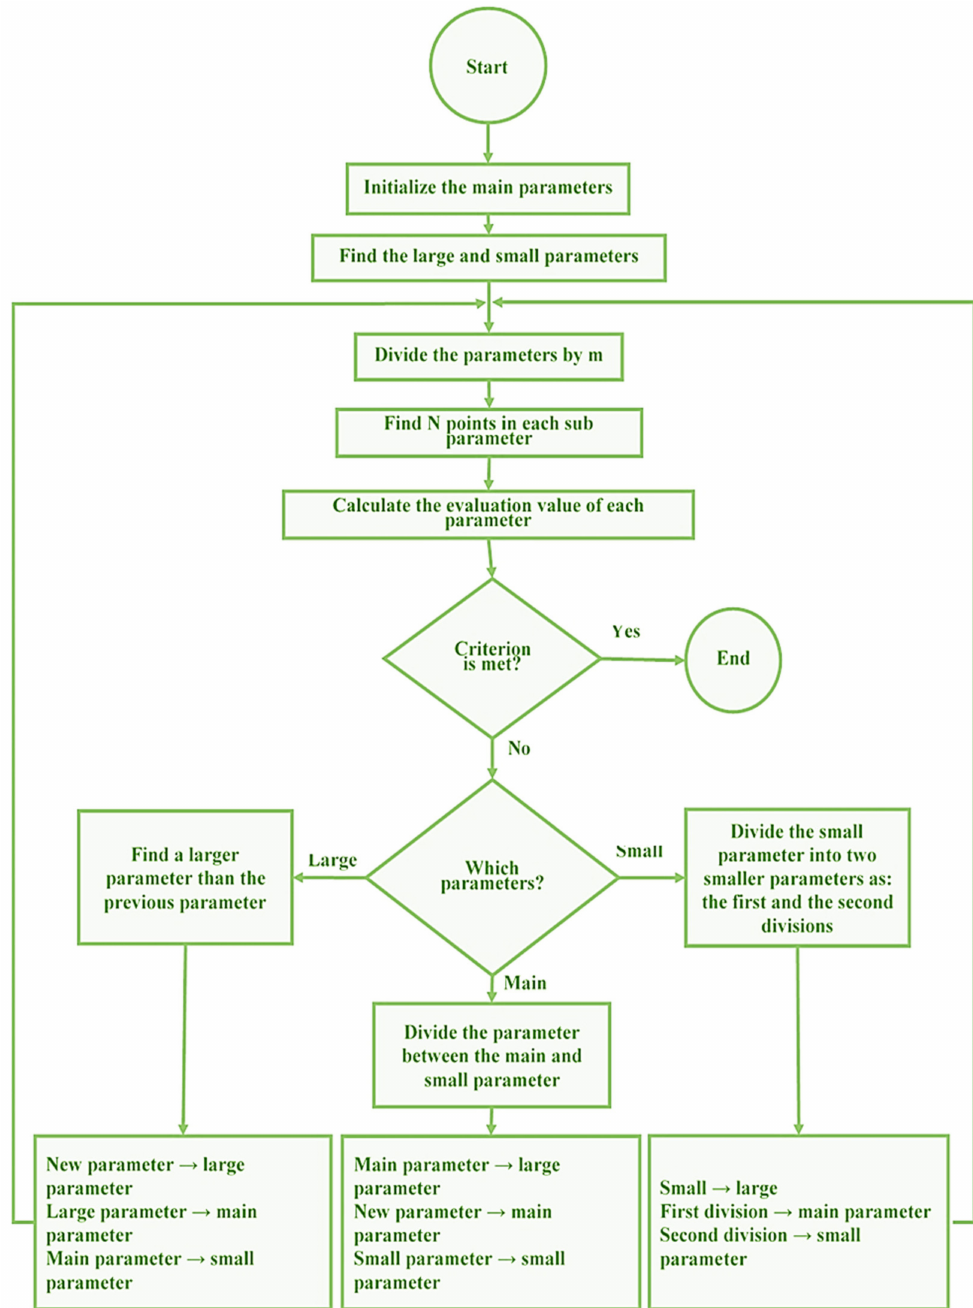
Figure 5. The division algorithm’s implementation procedure, from Kiehbadroudinezhad et al. [6] (cited in Kiehbadroudinezhad et al. [88]). With permission from John Wiley & Sons Ltd. Copyright © 2020; License Number: